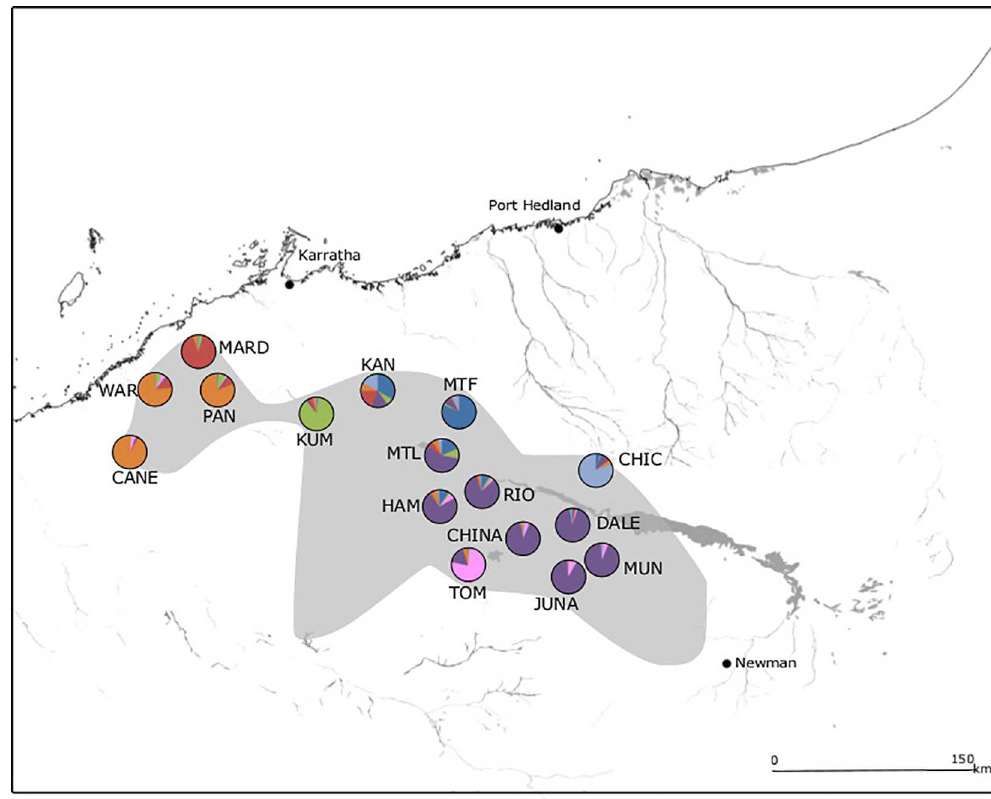
Fig 1. Geographical distribution of populations and inferred nuclear genetic clusters from TESS analysis for Acacia atkinsiana . The species distributionis shown in grey. Each colour represents a distinct genetic cluster and the size of each section indicatesthe proportion of each individual’s genomeassignedto each cluster, averagedacross the population.Major water courses and the Fortescue floodplainare shown.